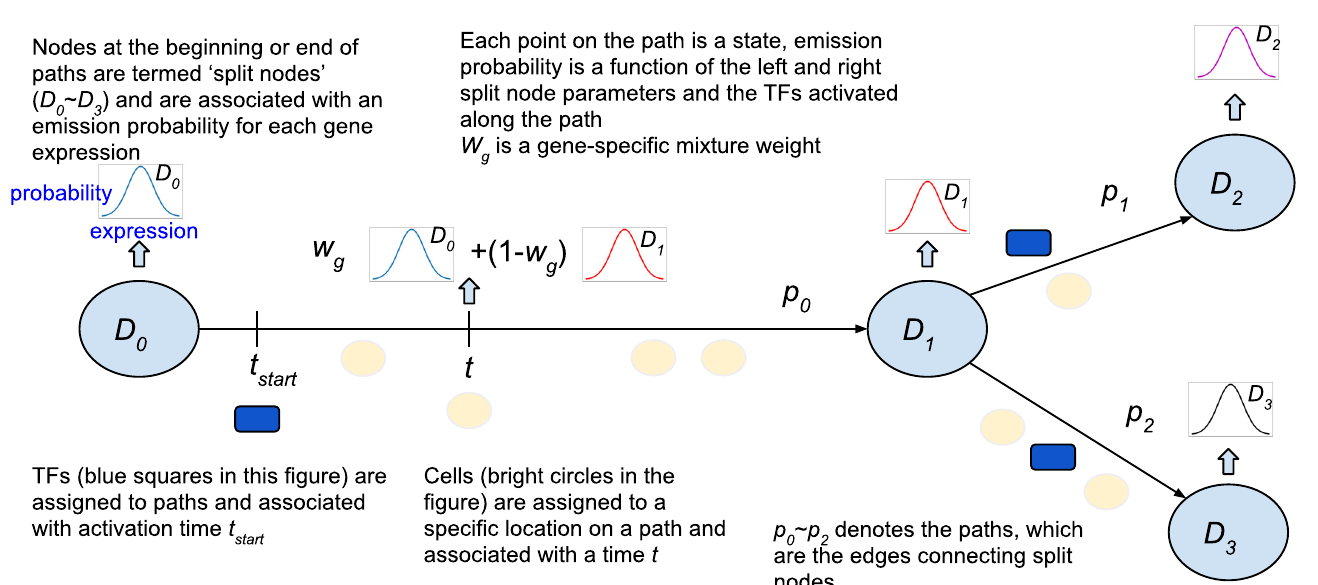
Fig 1. CSHMM-TF model structure and parameters. The figure presents the assignments of cells and TFs to the reconstructed branching model for the process studies. Each edge (path) represents a set of infinite states parameterized by the path number and the location along the path. We use a function based on parameters learned for the split nodes (nodes at the start and end of each path) and TF assignments to define an emission probability. Emission probability for a gene along a path is a function of the location of the state and prior TFs ( t and t start ) and a gene specific parameter k which controls the rate of change of its expression along the path. Split nodes are locations where paths split and are associated with a branch (transition) probability. The t_start parameter defines the TF activation time for a specific TF associated with the path. Cell assignment to paths is determined by the emission probabilities and the expression of specific TF targets for the TFs associated with the path. w is a vector of gene-specific mixture weight, where the weights are a non linear function which depends on ( t and t start ). See text for more